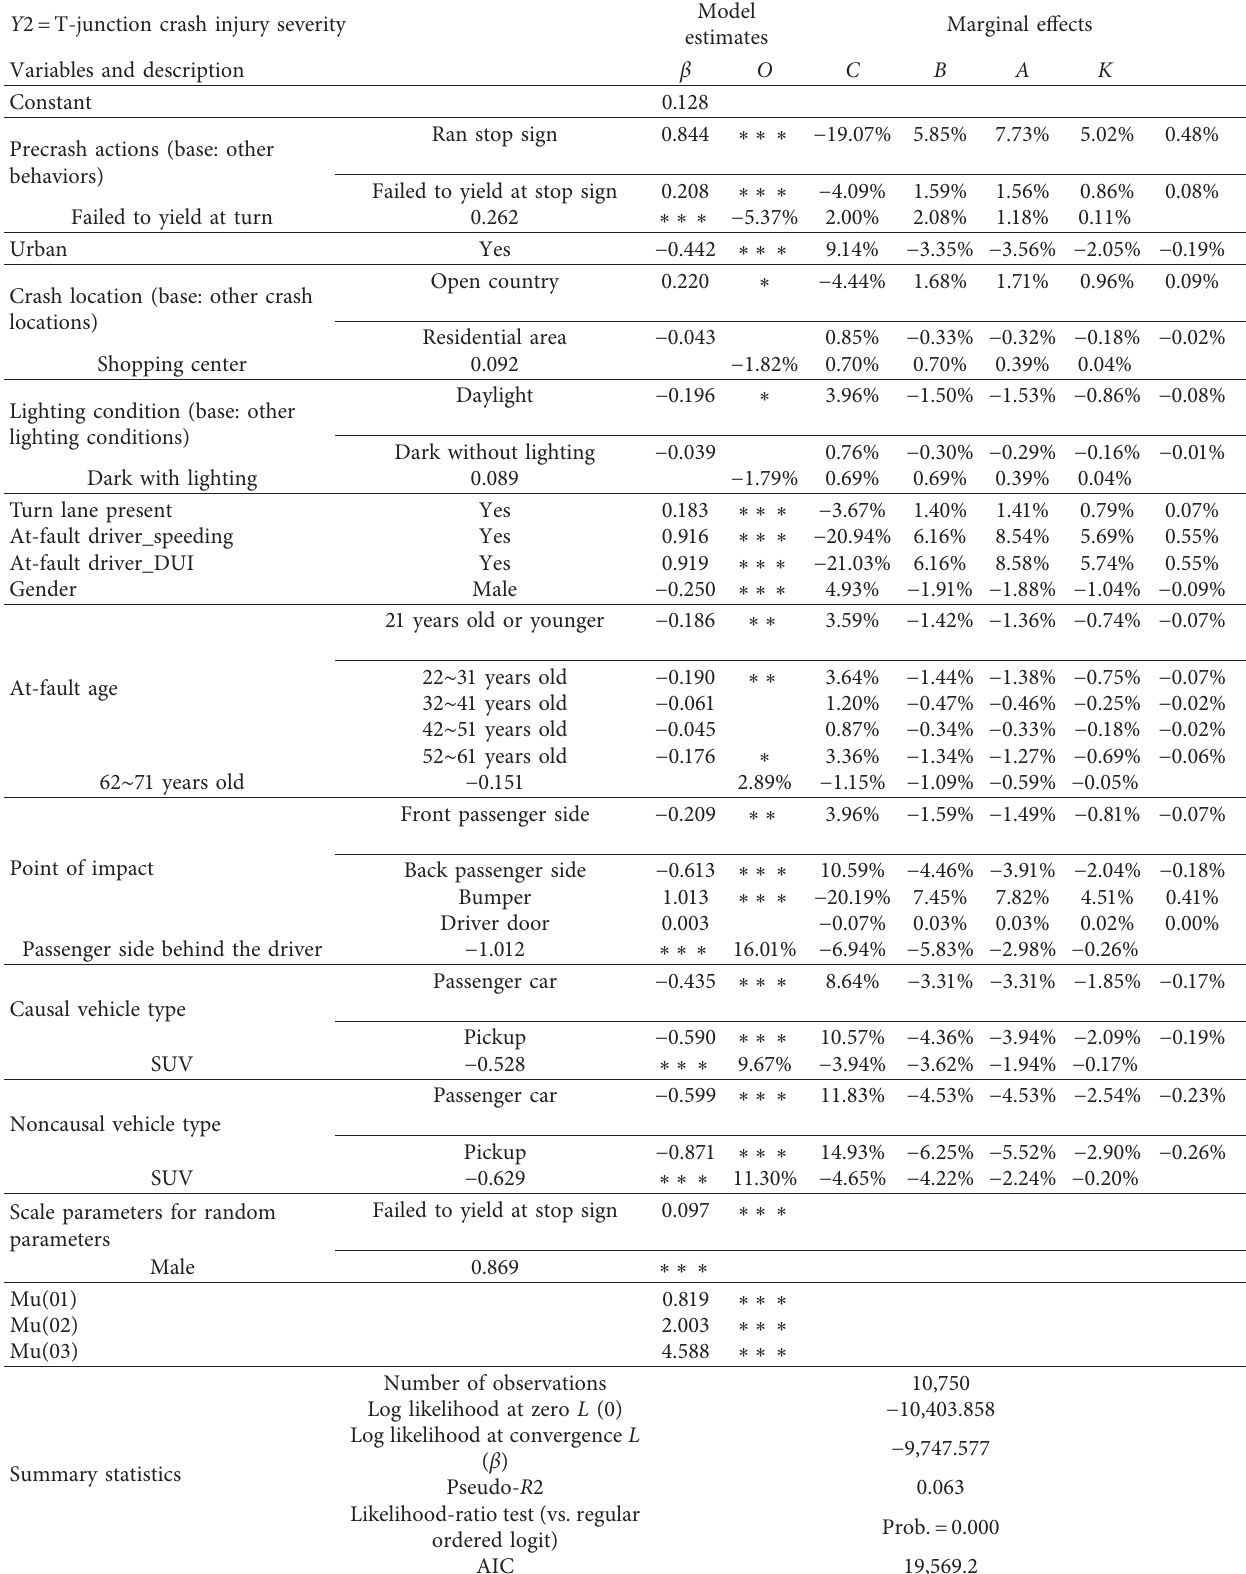
Table 7: Random-parameter ordered logit model of injury severity for side impact crashes at